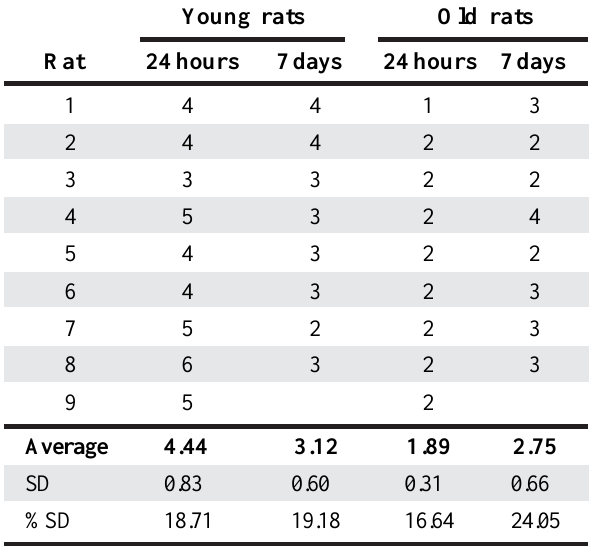
TABLE 2 - Mitotic figures in 5 fields